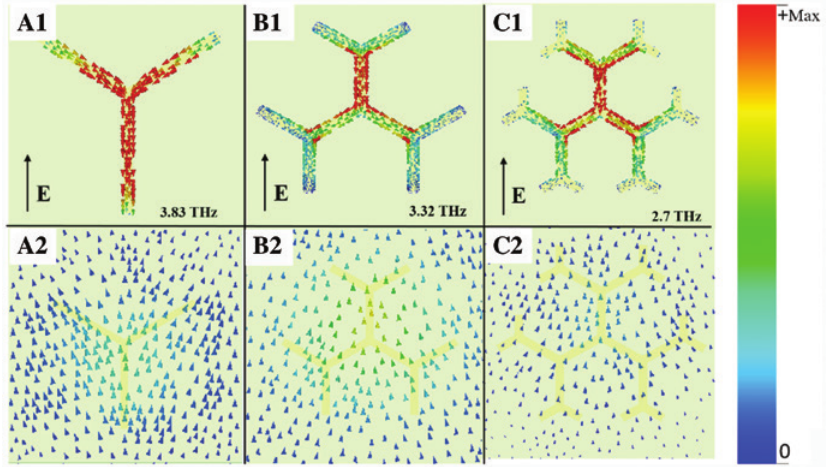
Figure 4: Surface current distribution. (A1–C1) Front of first-, second-, and third-fractal-order Cayley tree, respectively. (A2–C2) Bottom layer of the unit-cell structure at first resonance frequency for each fractal order under TE polarized incident wave: (A1, A2) first-order Cayley tree, f = 3.32 THz, (C1, C2) third-order Cayley tree f = 2. 7 THz, respectively. The solid arrow indicates the direction of order Cayley tree f 1 1